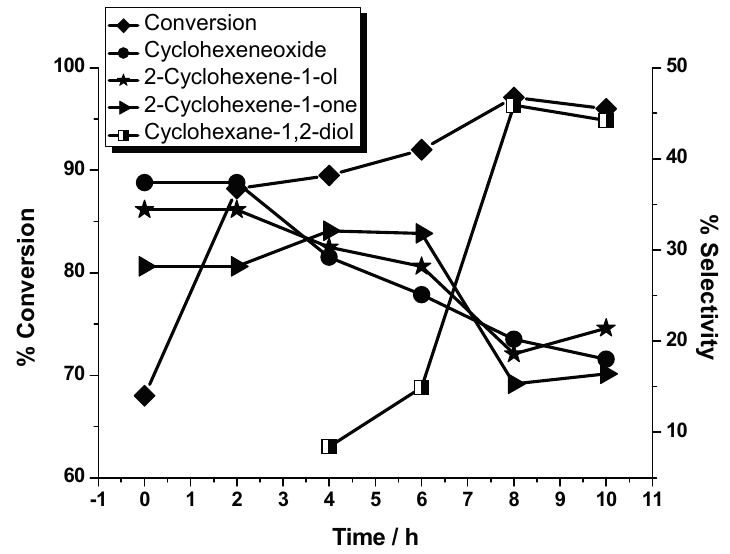
Figure 1. Plots showing percentage selectivity of cyclohexene oxide, 2-cyclohexene-1-one, 2-cyclohexene-1-ol and cyclohexane-1,2-diol formation and percentage conversion of cyclohexene as a function of time. Conditions: the amount of catalyst was 1 mol %; the mole